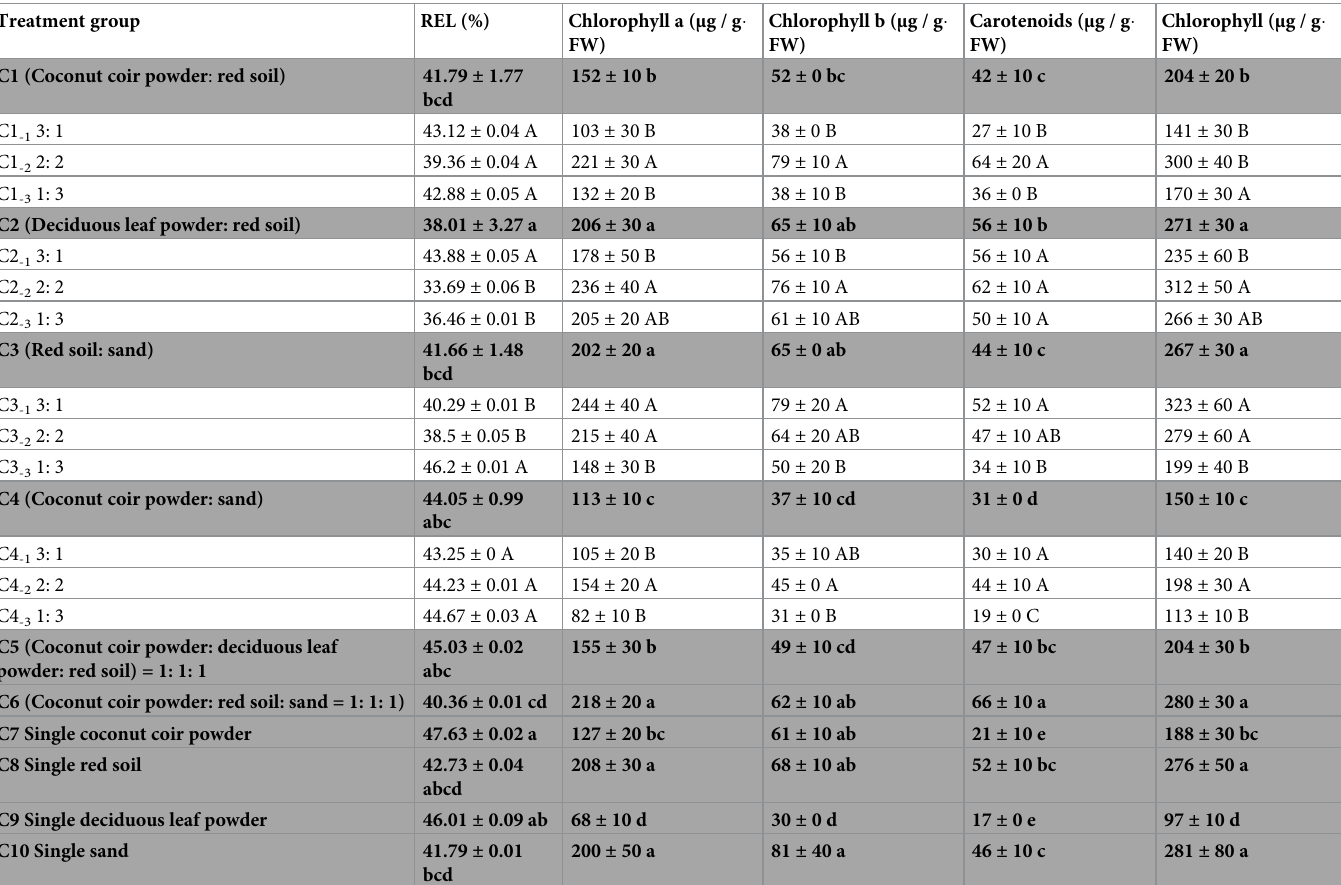
Table 4. Effect of substrate combinations and proportions on the leaf relative electrolyte leakage and pigment contents of D . odorifera . Different lowercase letters in the same column indicate the significant difference among different substrate combinations (P < 0.05). Different uppercase letters in the same column indicate the signifi- cant difference among the same substrate with different proportions (P <